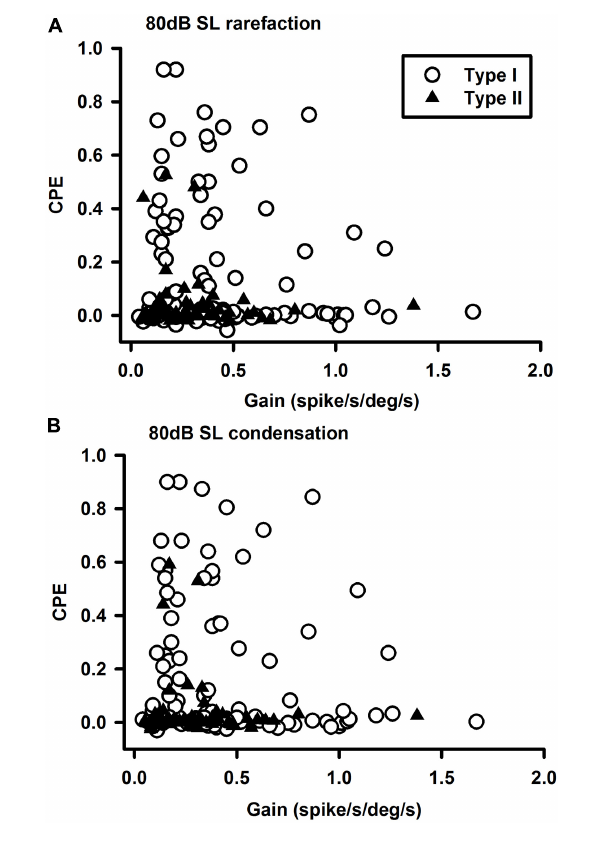
FIGURE 5 | Relationships between vestibular nucleus neuron’s sensitivities to clicks and head rotation at 80 dB SL. (A) Rarefaction and (B) condensation. The sound sensitivities (CPEs) of the Type I neurons were inversely correlated with their sensitivities to head rotations